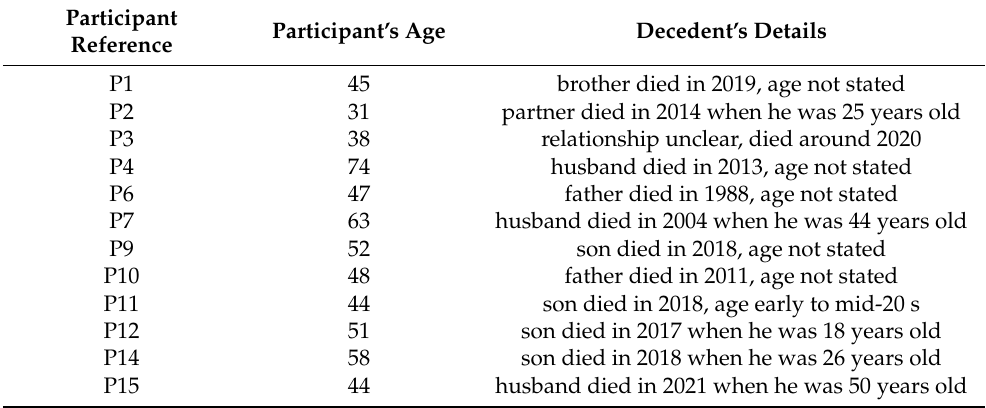
Table 1. Participant relationship to the